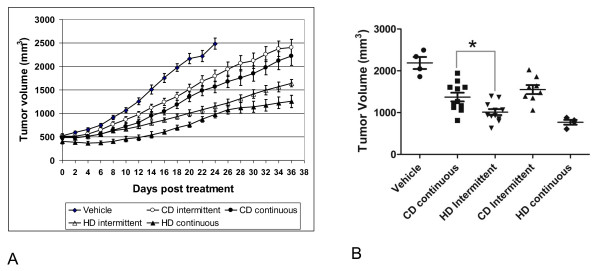
Effects of dosing and schedule of sorafenib on tumor growth. Treatment was initiated when tumors reached 12 mm in long axis (volume ~500 mm3) with the administration of vehicle or different doses and schedule of sorafenib orally as indicated. All animals were sacrificed and tumors were dissected ~36 days post treatment with the exception of vehicle treated mice which were sacrificed when tumors reached the mandated 20 mm sacrifice size (~22 days post treatment, volume ~2500 mm3). Figure 1A shows that treatment with high dose intermittent therapy inhibited tumor growth to a greater extent than conventional dose continuous and intermittent therapy. Data are presented as mean tumor volume with SEM. Figure 1B presents the tumor volume on the average day when vehicle treated tumors reached 20 mm in long axis (~22 days post treatment). The tumor volume of mice with high dose intermittent therapy is significantly smaller than that of conventional dose continuous therapy (P < 0.05) while the volume did not differ in the high dose intermittent vs high dose continuous or conventional dose intermittent vs conventional dose continuous arms (P > 0.05).